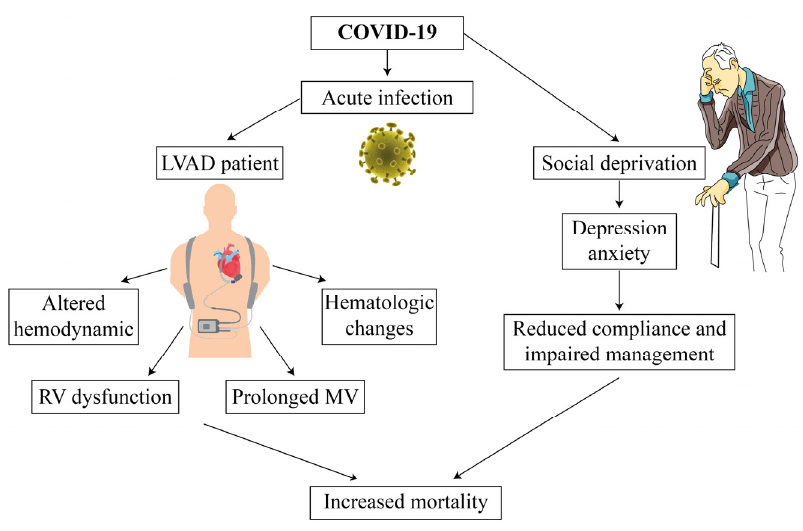
Figure 1. The Potential Implications of COVID-19 on LVAD Patients.